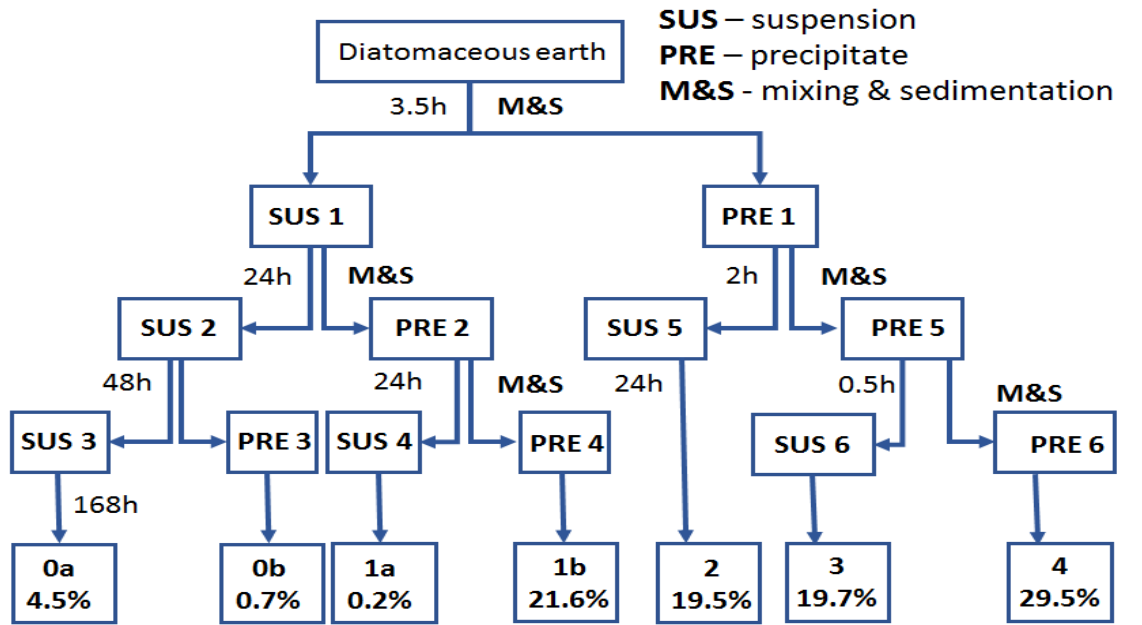
Figure 5. Fractionation of diatomaceous earth and the percentage share of each fraction of diatomaceous earth after fractionation.